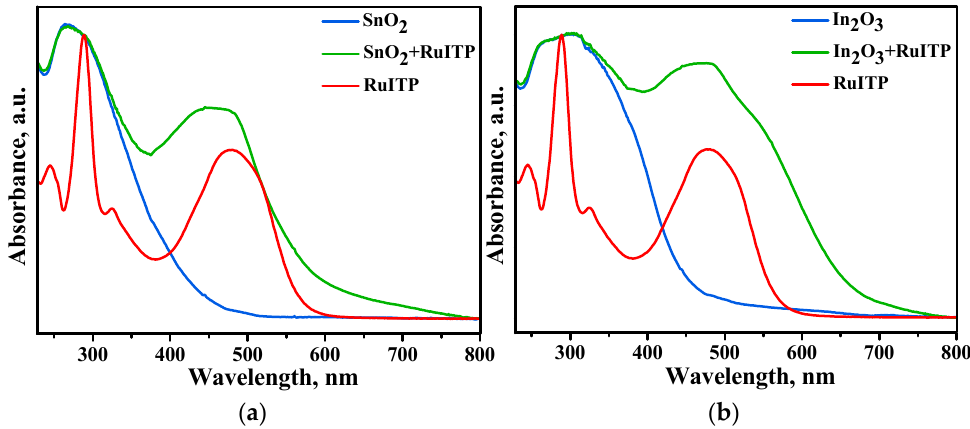
Figure 5. Absorption spectra of the RuITP dye, unmodified and sensitized nanocrystalline SnO 2 ( a ) and In 2 O 3 ( b ).